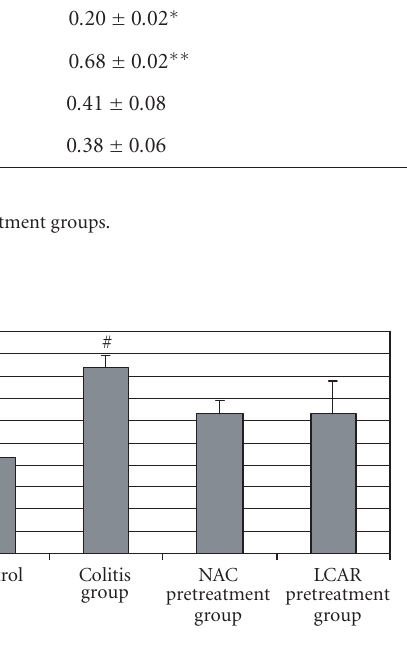
Figure 1. Plasma MDA (malondialdehyde) levels in AA-induced colitis in rats. Data are mean ± SD of 10 rats per group. #, colitis group was significantly di ff erent from other groups ( P < . 001); ∗ , control group was significantly di ff erent from pretreatment groups ( P < .